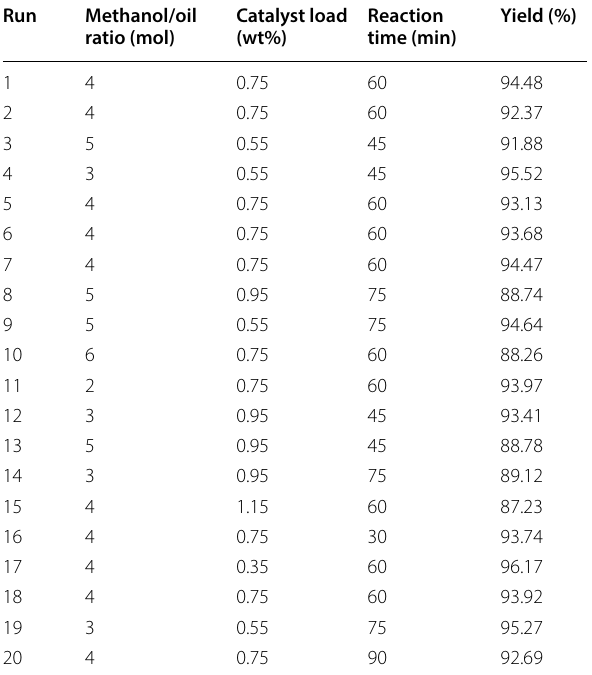
Table 5 Experimental design matrix and the